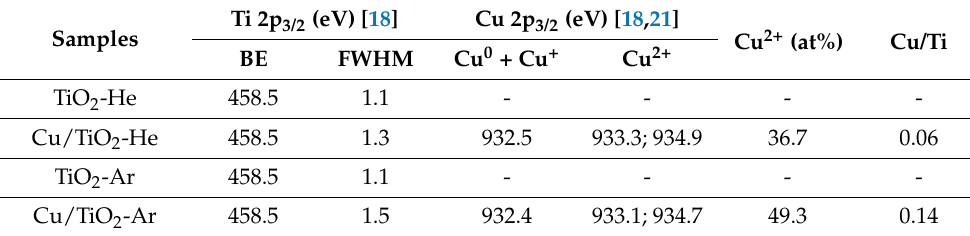
Table 2. XPS analysis of TiO 2 and Cu x O y /TiO 2 elaborated under He and Ar atmospheres.